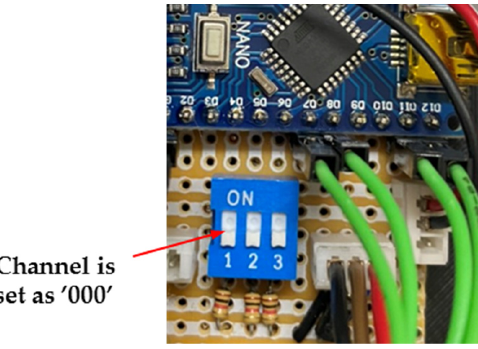
Figure 9. The proposed IoT-based intelligent LED light with channel set to “000”.